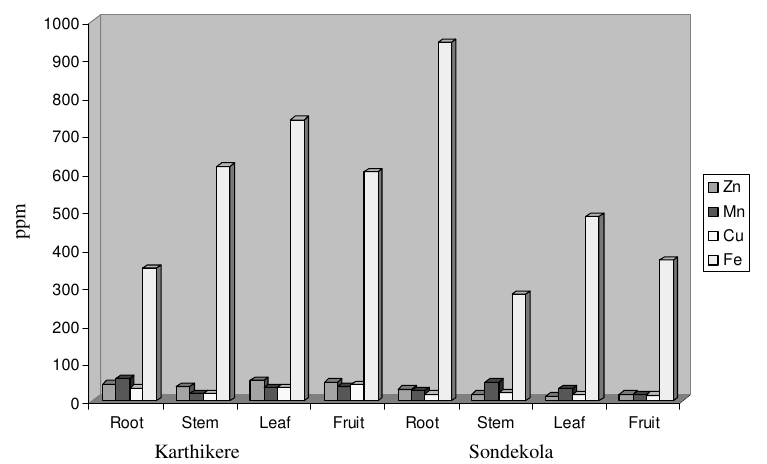
Figure 3. Variation of micro elements of the root, steam, leaf and fruit samples of Withania somnifera (Linn.) Dunal at Karthikere and Sondekola of Karnataka,